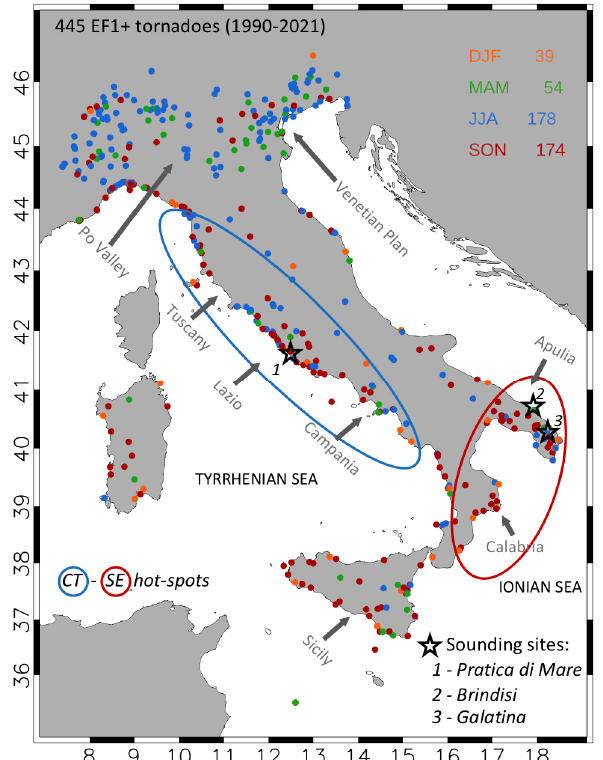
Figure 1. The selected EF1+ tornadoes over Italy in the whole study period (1990–2021) and other locations cited in the manuscript. Figure reprinted/adapted with permission from Figure B1 of [17]. 2022, Elsevier. The ellipses indicate the main tornadic hotspots considered in the present study, i.e., CT (blue ellipse) and SE (red ellipse) regions. On the top right, the different colors refer to